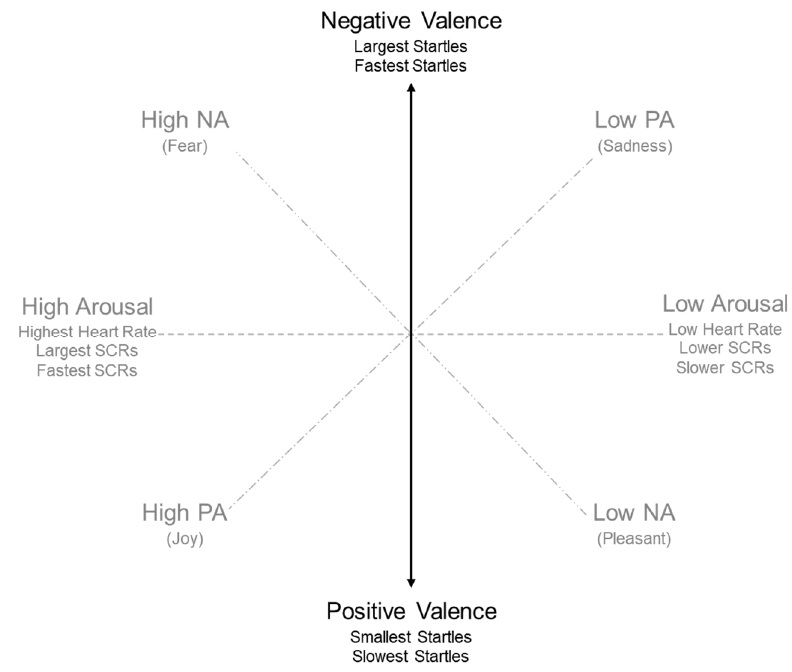
Figure 1. Graphical representation of the valence-affect model [26] .